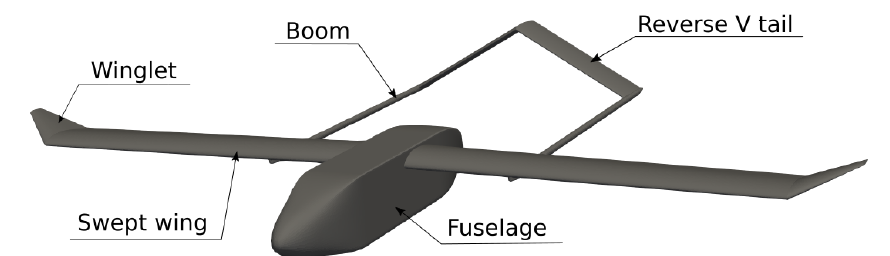
Figure 1. CAD model of the simplified